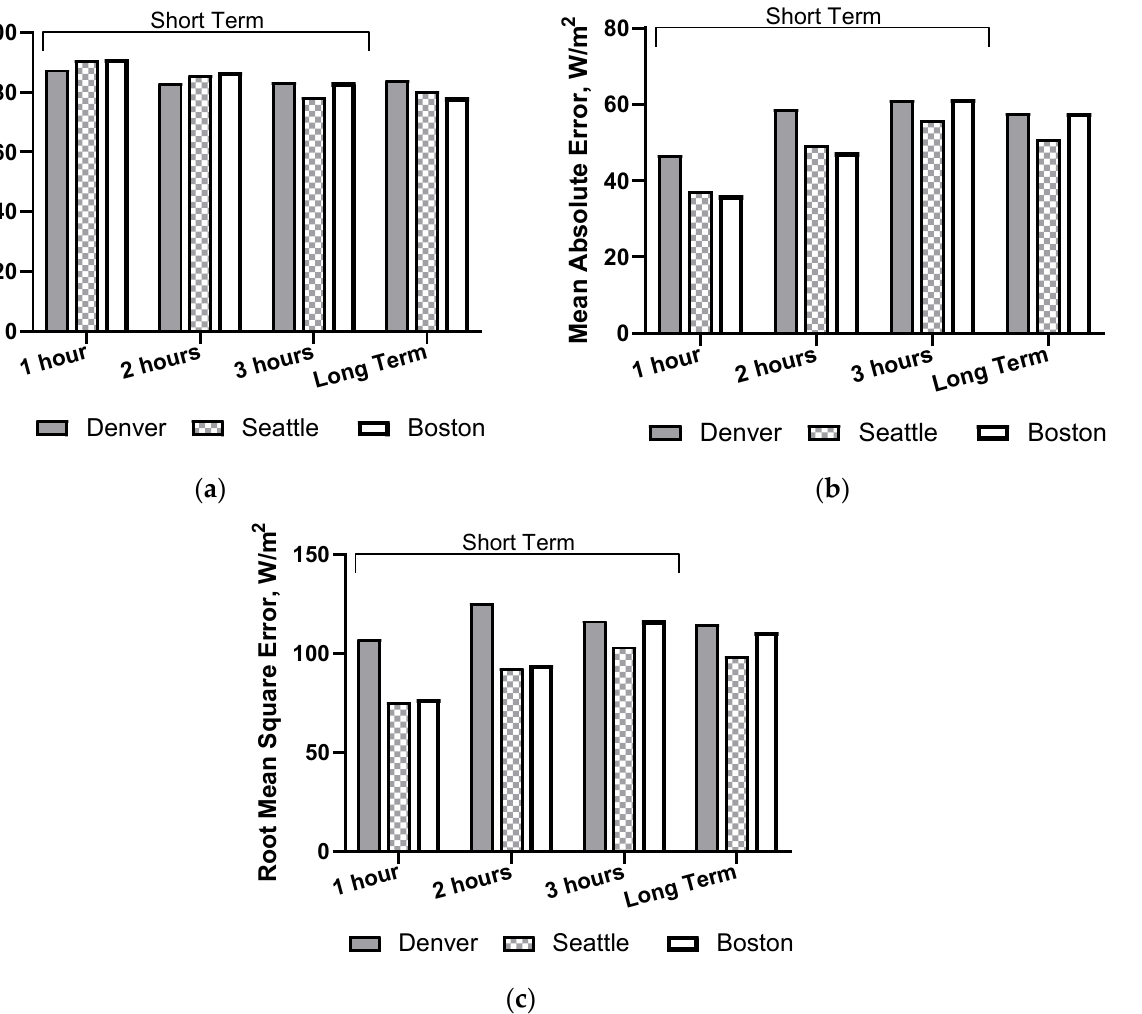
Figure 13. DCF accuracy, evaluated in three cities using all evaluation metrics. ( a ) Coefficient of determination (R 2 ) ( b ) Mean absolute error ( c ) Root-mean-squared error.